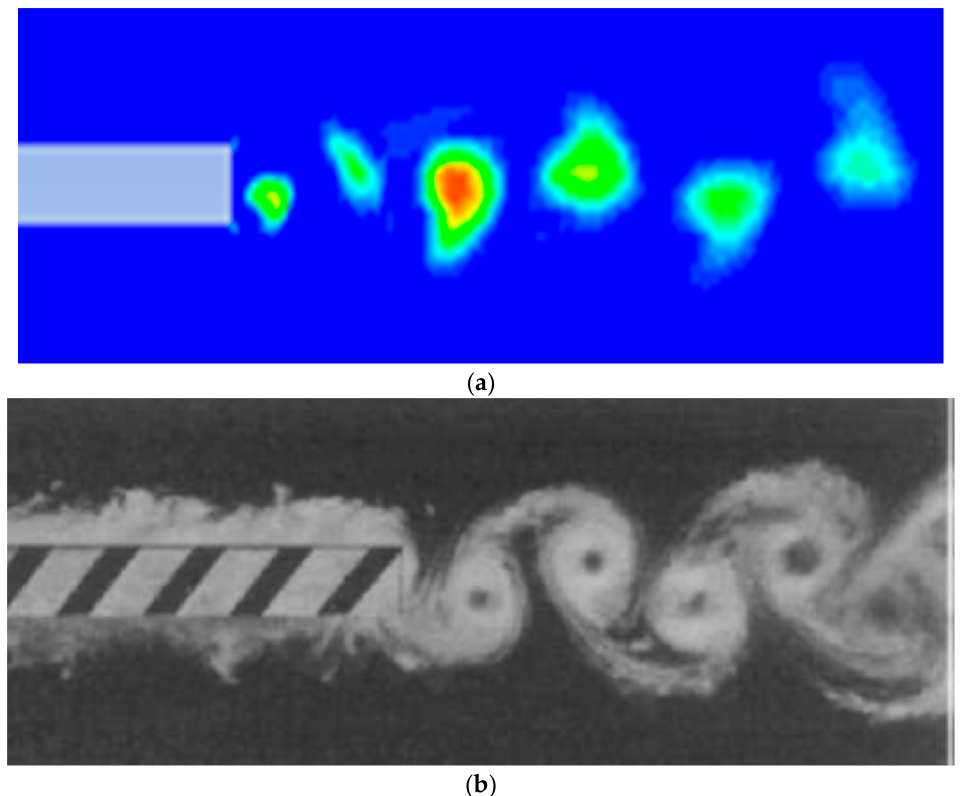
Figure 11. Motion law of plate wake vortex. ( a ) Present result. ( b ) Reference result [16].